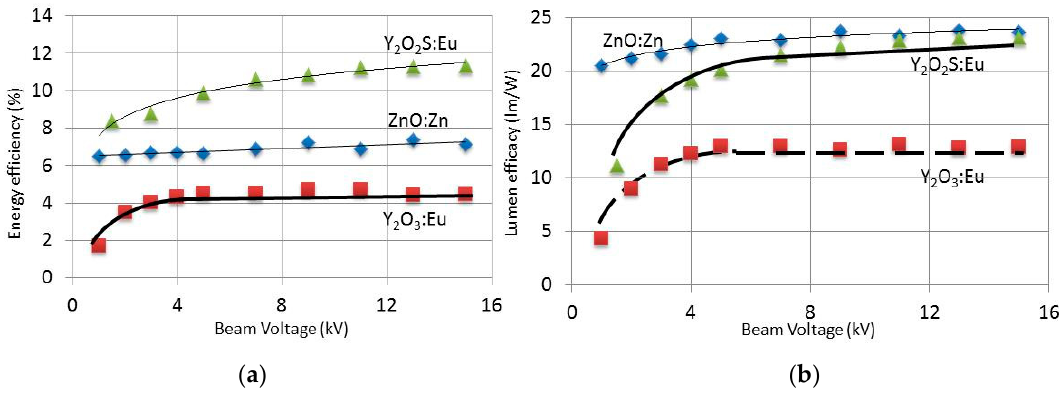
Figure 4. Cl efficiency of ZnO:Zn, nanosized Y 2 O 3 :Eu 3+ and Y 2 O 2 S:Eu 3+ as function of beam voltage at shield bias –50 V and current density of 1 μ A/cm 2 : ( a ) energy efficiency; and ( b ) luminous efficacy.